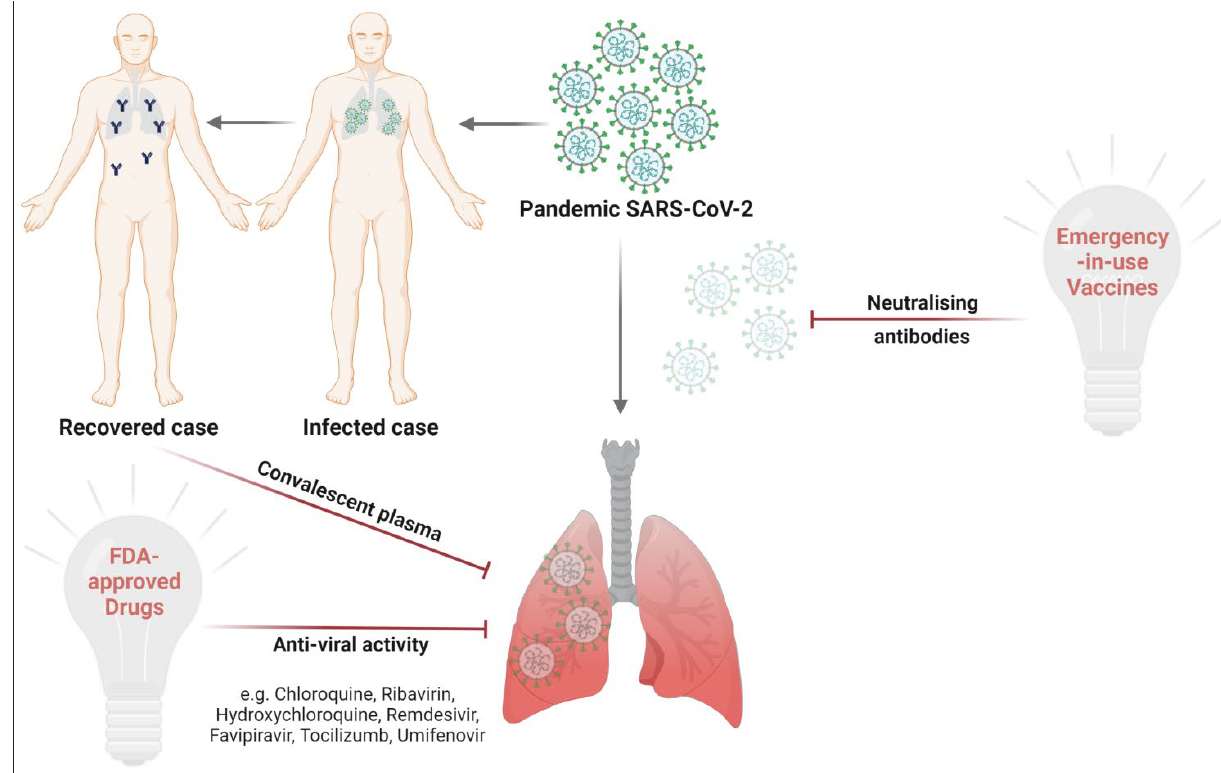
Figure 2. Drug repurposing for fighting COVID-19 and the introduction of different types of vaccines for prophylaxis. Figure has been created using BioRender.com.